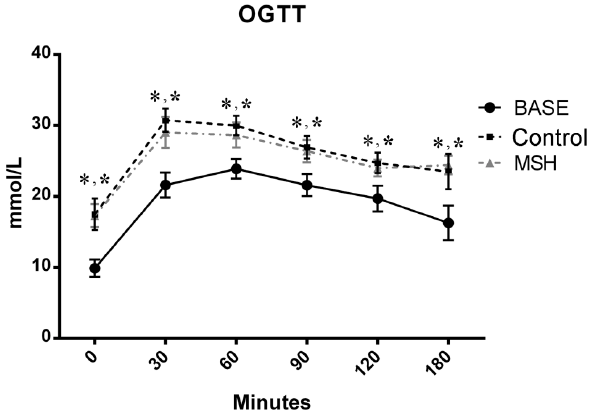
Figure 1. Results of the Oral Glucose Tolerance Test (OGTT) carried out at the start and on the 6th week of the experiment. No significant differences were seen between alpha-MSH-treated and untreated ZDF animal-groups. One-way ANOVA, all data is presented as mean ± SEM. * vs. BASE, p < 0.05.